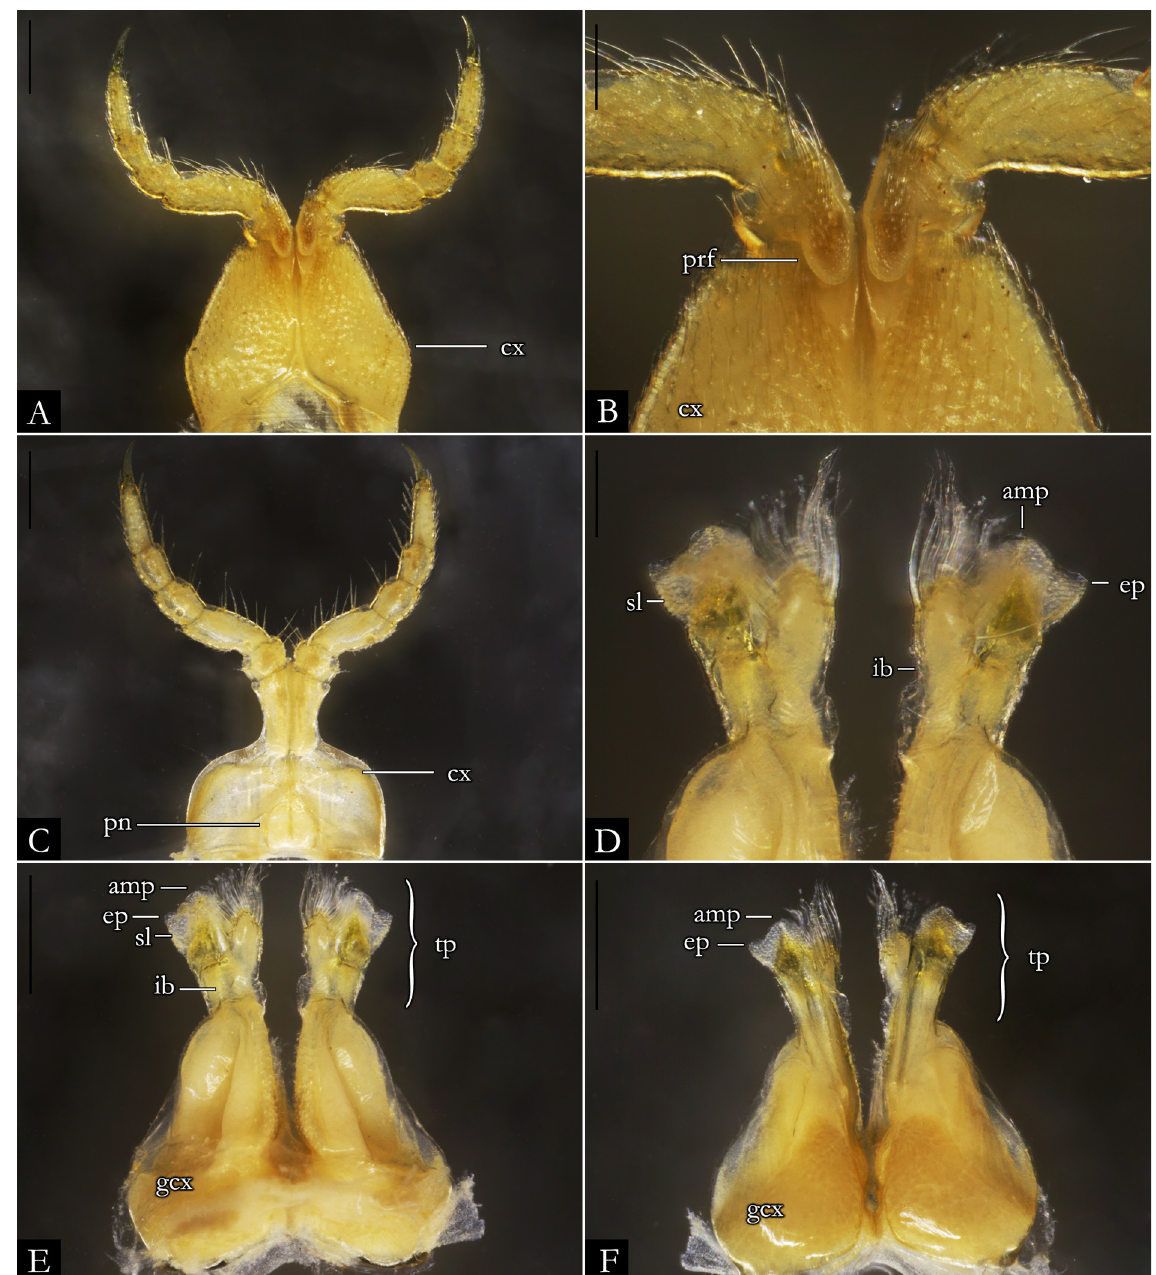
Fig. 130. Pseudonannolene strinatii Mauriès, 1974, ♂ (IBSP 7633). A . First leg-pair. B . Detail of prefemur. C . Second leg-pair. D . Detail of telopodites, in anal view. E . Gonopods, in anal view. F . Gonopods, in oral view. Abbreviations: see Material and methods. Scale bars: A, C, E–F = 0.5 mm; B, D = 0.2